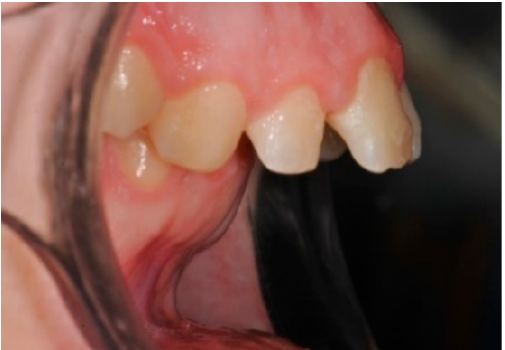
Figure 5. Overjet.